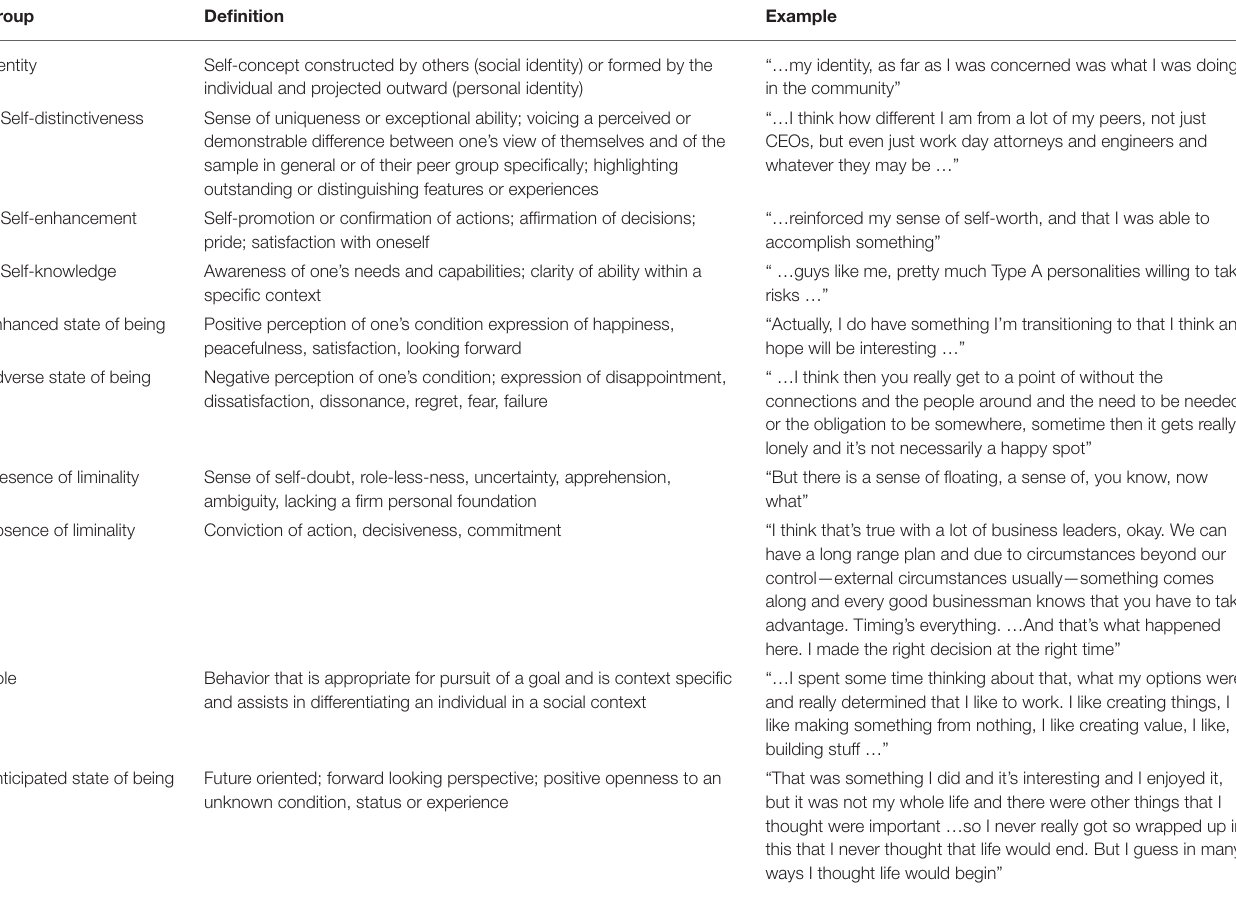
TABLE 1 | Coding scheme group definitions.